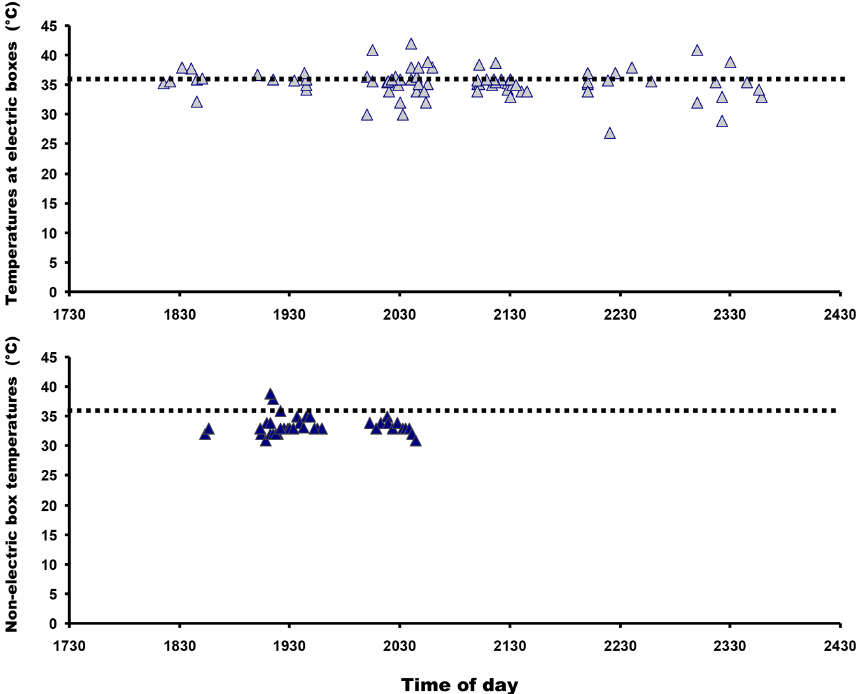
Figure 6. Lizard locations in relation to heated panels (top graph) and areas without heat panels in relation to minimum preferred body temperatures known in this species shown as dotted lines. The graphs suggest that lizards associated with heated panels were more likely to have body temperatures within the minimum PBT than those lizards that were